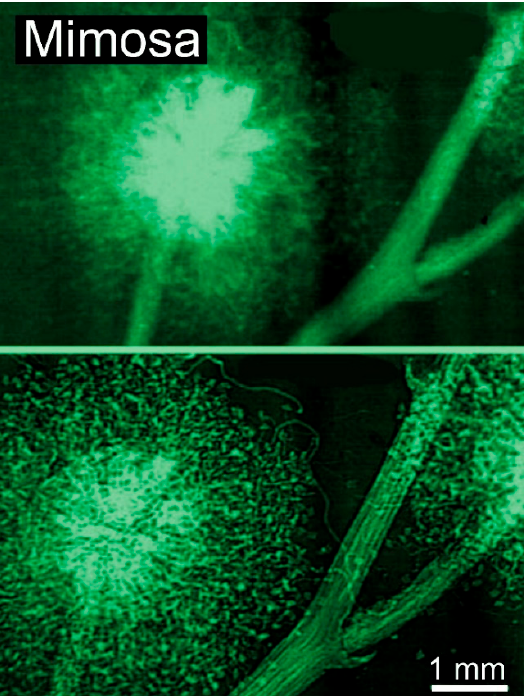
Figure 6. Direct comparison of a conventional absorption radiograph and a coherence-based radio- graph: mimosa flower [12]. The result was obtained on the Elettra synchrotron in Trieste under the leadership of Giuliana Tromba.